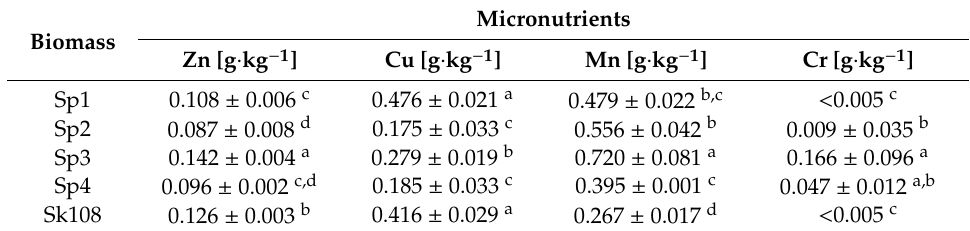
Table 4. Contents of micronutrients in methanotrophic